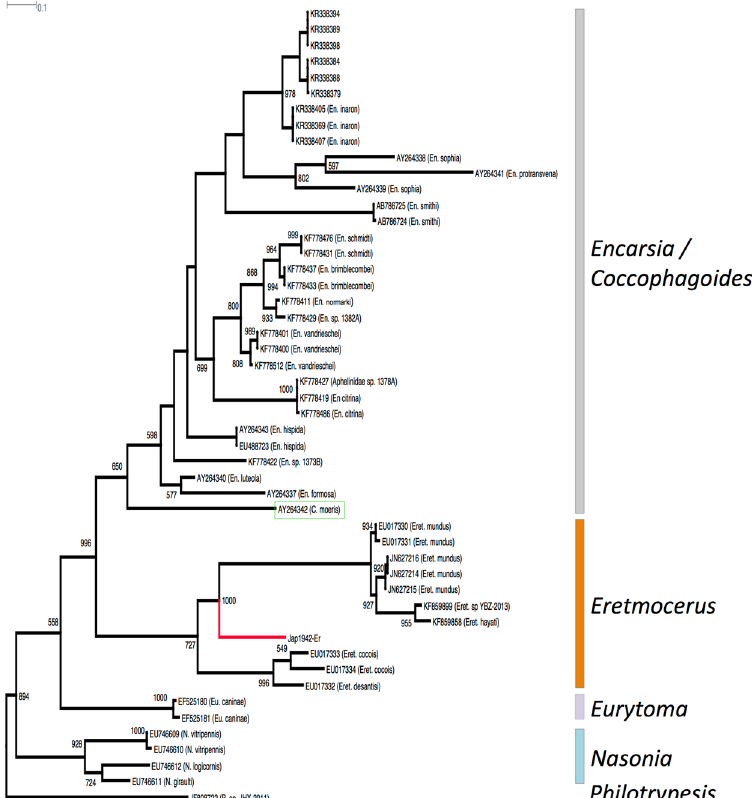
Figure 3. Phylogenetic placement of the unknown hymenopteran entity detected in the gDNA of the 1942 Japan Bemisia sp. The Hymenoptera is likely a parasitoid wasp species of the Eretmocerus genus based on partial (657 bp) mtCOI gene phylogeny, being placed within the ‘ Eretmocerus ’ clade (indicated by a red branch). The Aphelinidae wasps (‘ Encarsia / Coccophagoides ’ and ‘ Eretmocerus ’ species) formed sister clades with 99.6% node confidence. Green coloured box indicates Coccophagoides moeris . Outgroups used are Eurytoma caninae (Eurytomidae), Nasonia species (Pteromalidae) and Philotrypesis species (Pteromalidae). Node confidence of ≥ 50% (estimated from 1,000 bootstrap replications) are